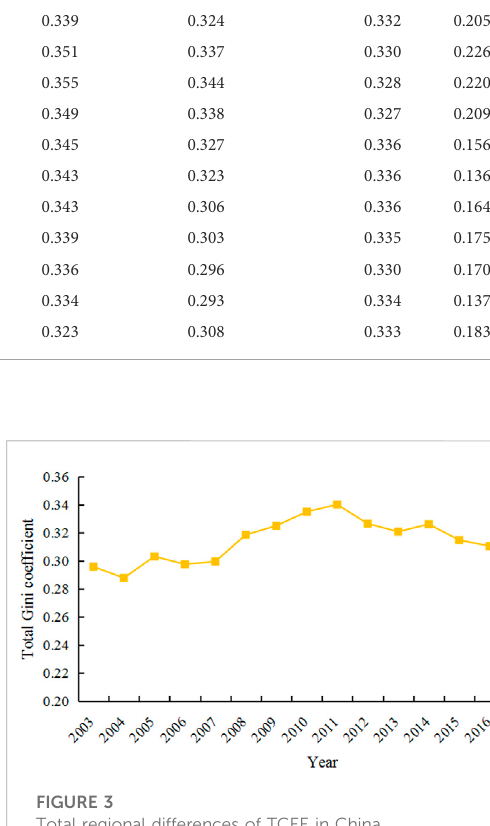
FIGURE 3 Total regional differences of TCEE in